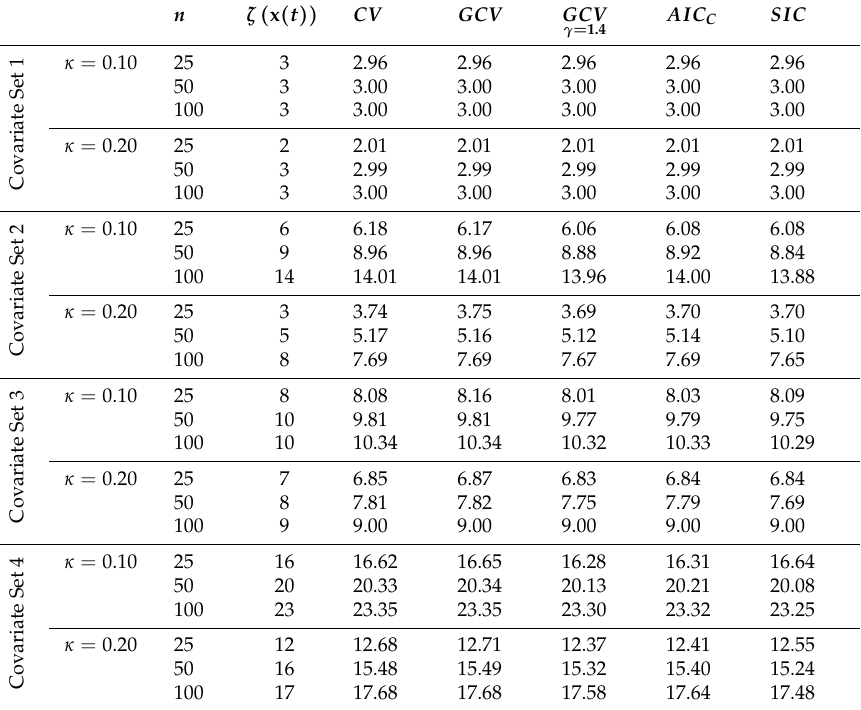
Table 6. Analogous to Table 5 for parameter curve β 2 ( t ) .